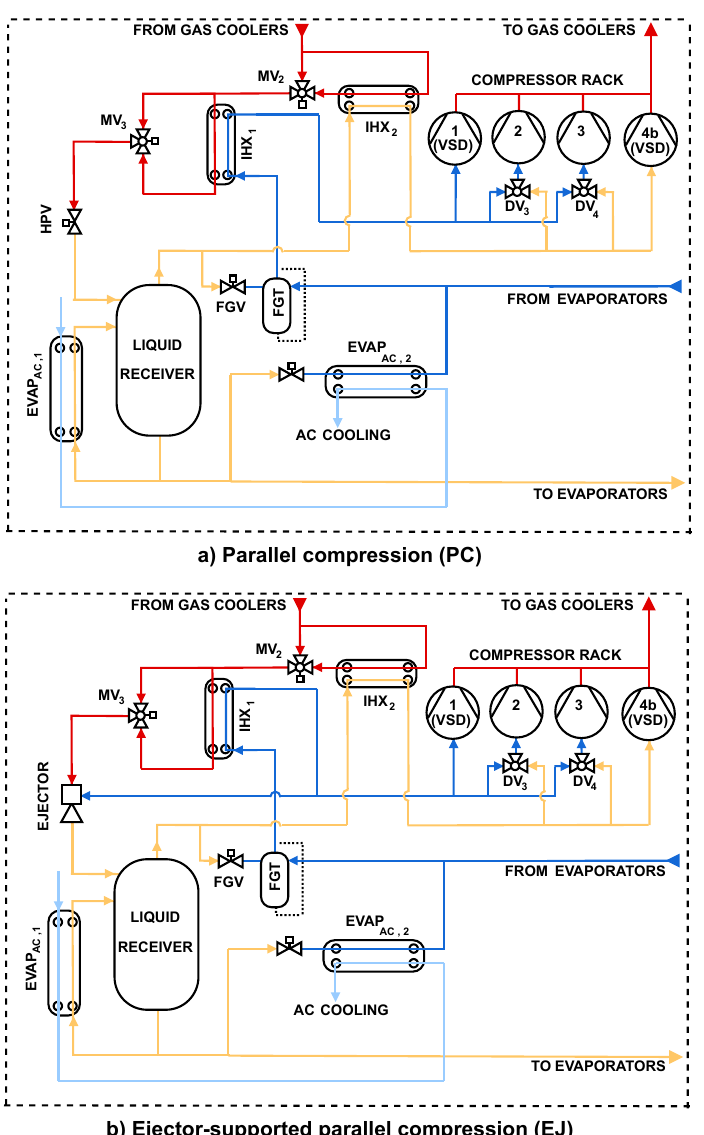
Figure 2. Alternative design of CO 2 integrated system with ( a ) parallel compression (PC), and ( b ) ejector-supported parallel compression